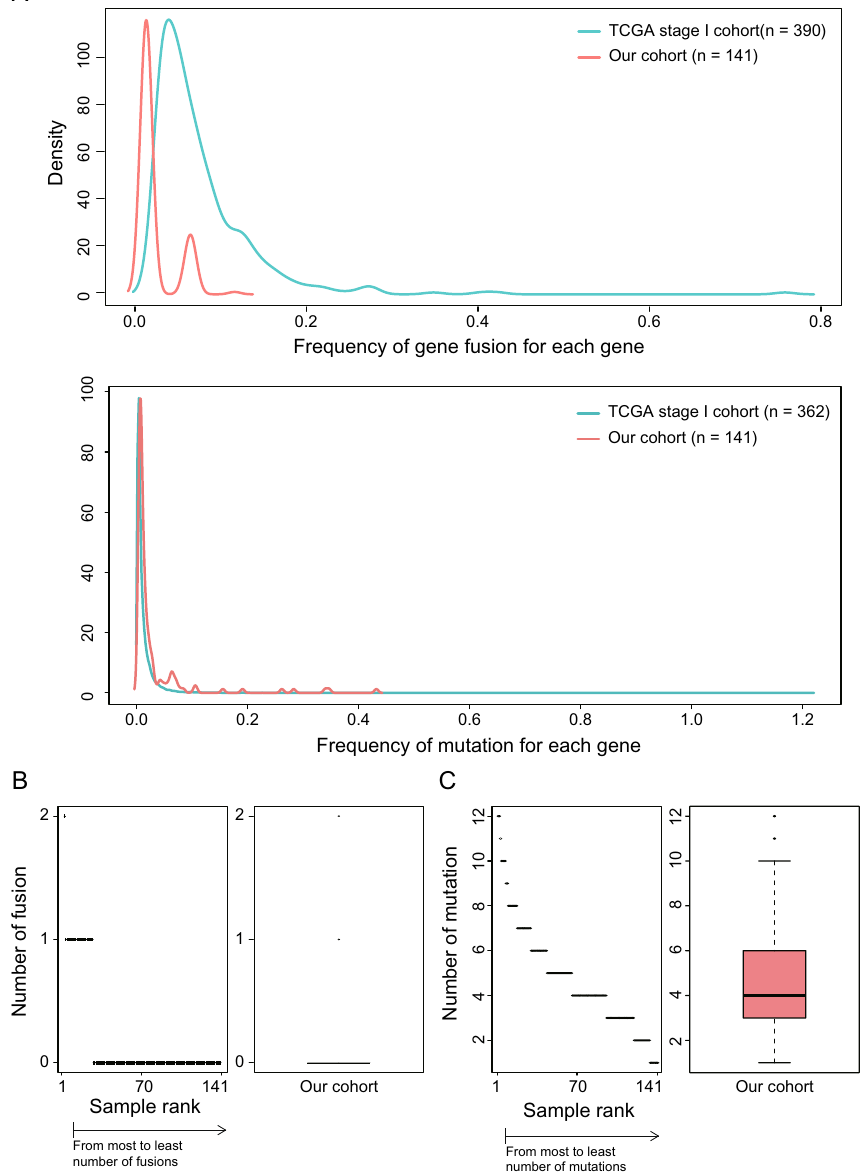
Figure 1. Comparison of the frequency distribution of gene mutations and fusions between our NSCLC cohort and TCGA cohort. ( A ) All fusion genes and mutations were identified from our cohort and TCGA cohort according to the same variant calling procedures (top). Detailed distribution of fusion genes in our cohort (bottom). ( B ) The number of fusion genes was described accordingly by the sample rank that was sorted from most to fewest fusions (left), and the distribution of the number of fusion genes is shown by a box plot (right). ( C ) Detailed distribution of mutations in our cohort. The number of mutations was described according to sample rank that was sorted from most to fewest mutations (left), and the distribution of the number of mutations is shown by a box plot (right). Only the samples that had at least one variant were analyzed for their